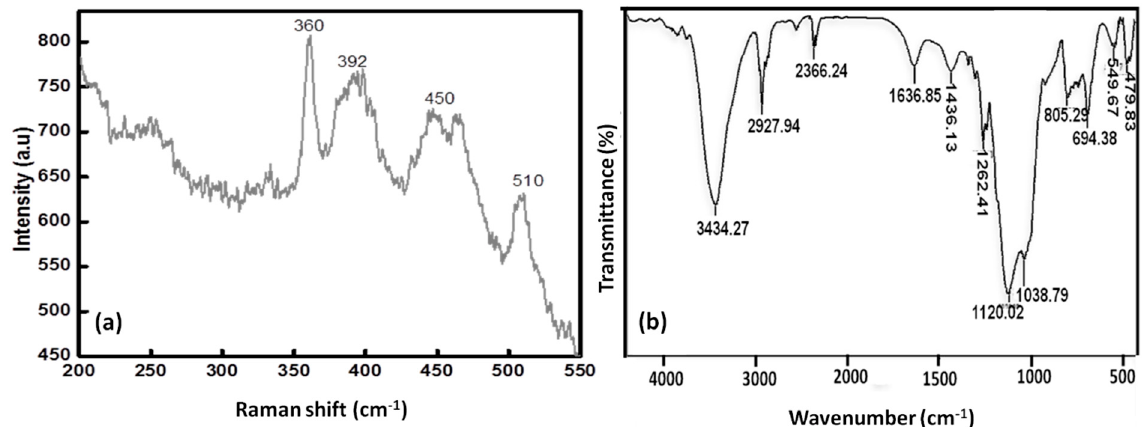
Figure 3. Typical ( a ) Raman scattering and ( b ) FTIR spectrum of as-synthesized MPTMS@Gd 2 O 3 nanoparticles.